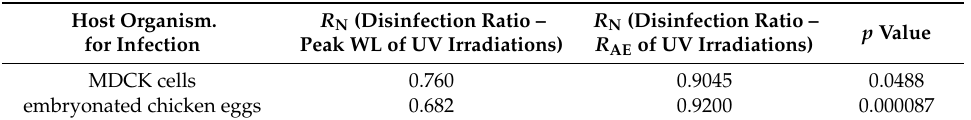
Table 2. The Di ff erence in Correlation Coe ffi cients between the Disinfection Ratio and Peak Wavelength or R AE of UV